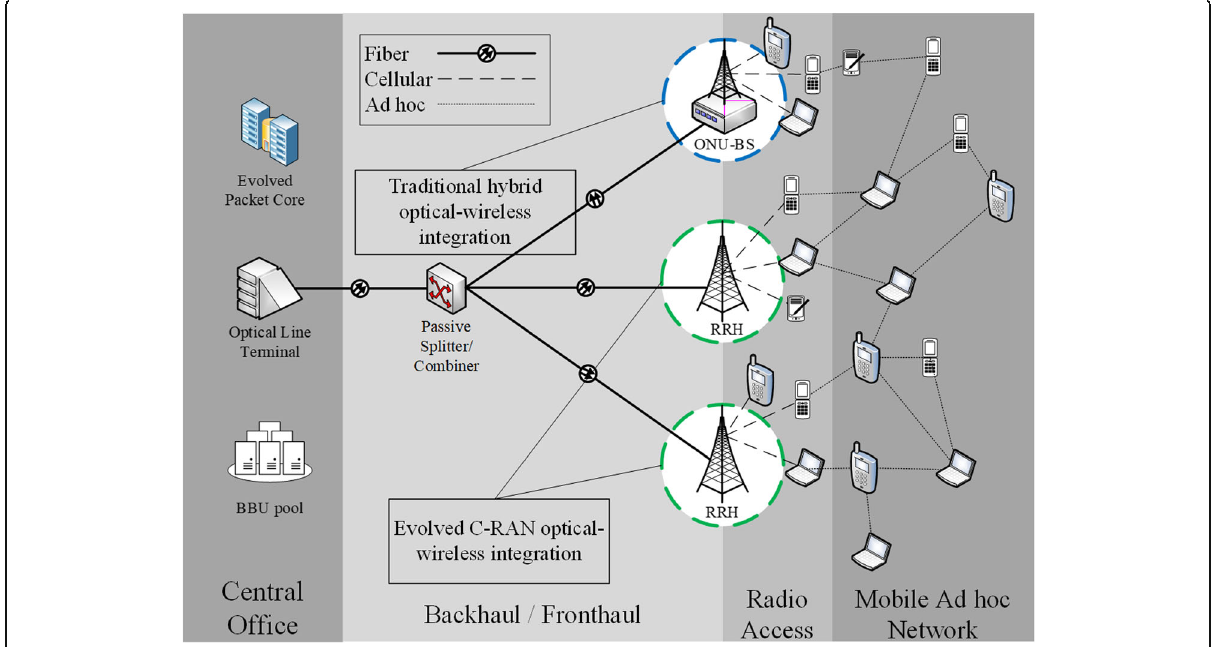
Fig. 1 FiWi and MANET domains combined into our federated